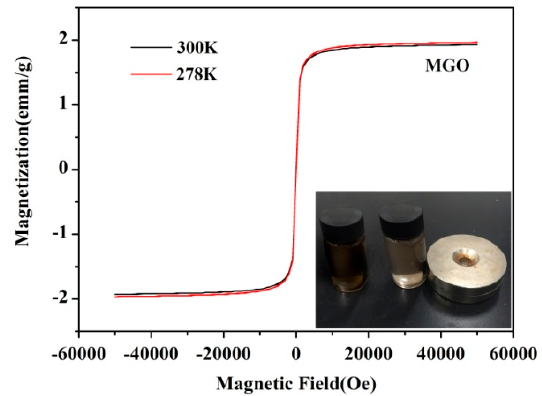
Figure 5. Magnetization curve of MGO. The inset shows magnetic separation of adsorbents from the solution.